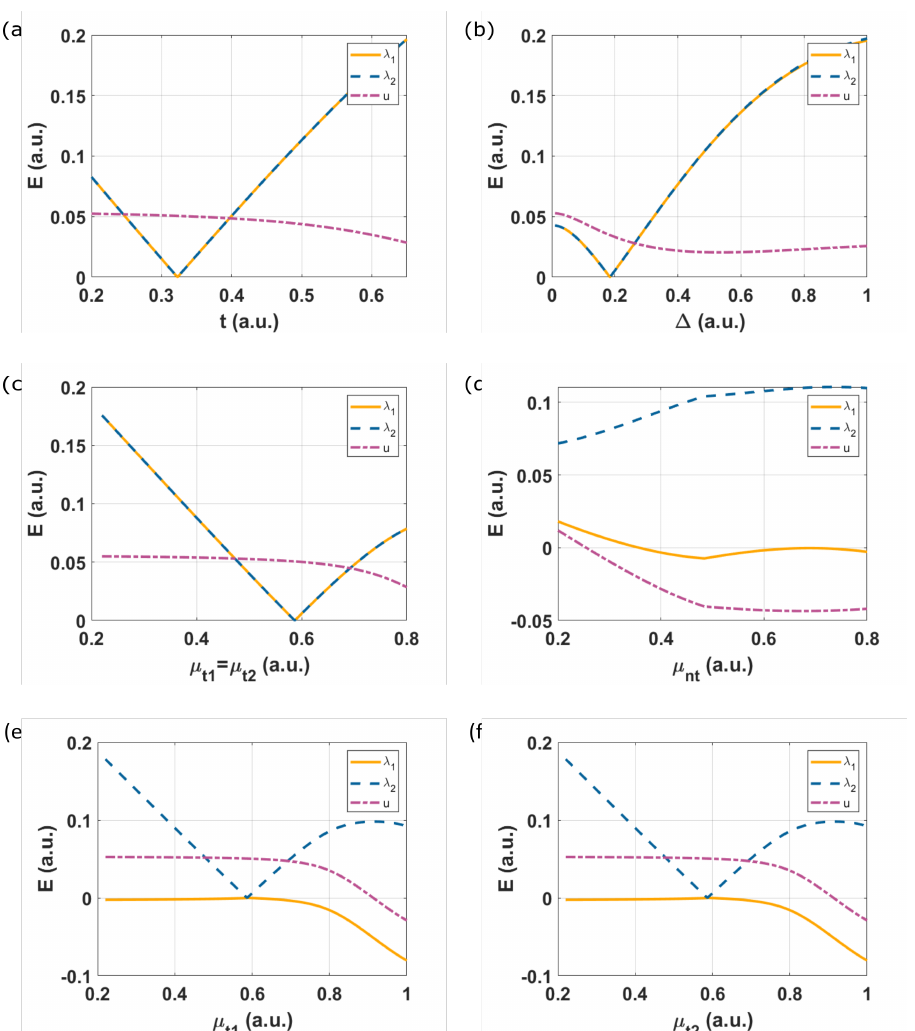
Figure 16: We plot interaction strengths λ Hamiltonian in Eq. 11. The interaction strengths are plotted as a function of one parameter keeping the others fixed to the SYK point paramteric values mentioned in Fig. 6: We plot λ , λ , u as a function of Fig.(a). t , Fig.(b). ∆ , Fig.(c). µ 1 2